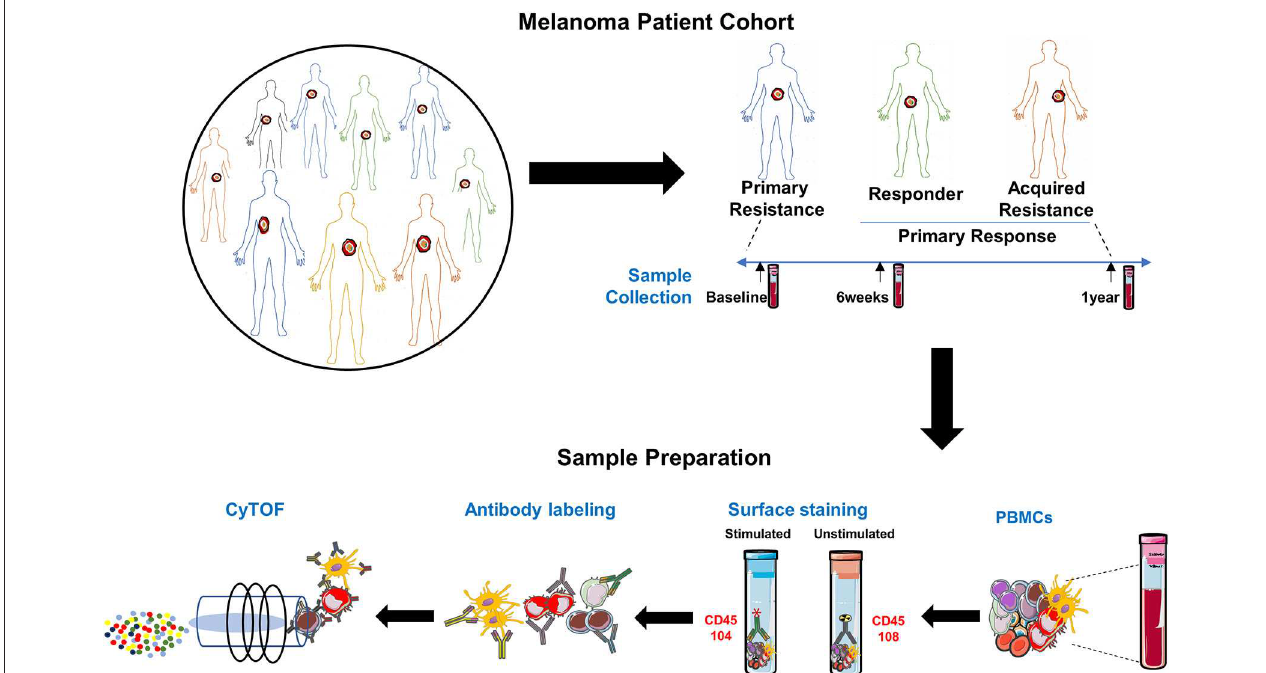
FIGURE 1 | Experimental schema. Experimental setup for processing PBMCs from matched samples before and after anti-PD-1 immunotherapy. Samples ( n = 97) comprised 36 from melanoma patients prior to beginning anti-PD-1 treatment [Primary Resistance (PR) = 17, Responders (R) = 10 and Acquired Resistance (AR) = 9]; 39 from 6 weeks post-treatment (PR = 19, R = 11, and AR = 9) and 18 from the 1 year time point (PR = 10, R = 2, and AR = 6). PMA/Ionomycin stimulated cells were stained with 104Pd metal tagged anti-CD45 antibody while unstimulated cells from the same sample were stained with 108Pd metal tagged anti-CD45 antibody. Barcoded samples were washed, pooled, and subsequently stained with a panel of 39 antibodies, each conjugated to a different metal isotope, and analyzed by mass cytometry. Cells were nebulized into single-cell droplets, and an elemental mass spectrum was acquired for each. The integrated elemental reporter signals for each cell were then analyzed using a supervised gating strategy (FlowJo). For some analyses, responder and acquired resistance groups were pooled into a primary responder group equivalent to the responder groups in published studies in which progression after 3 month RECIST assessment was not used to subdivide the responder